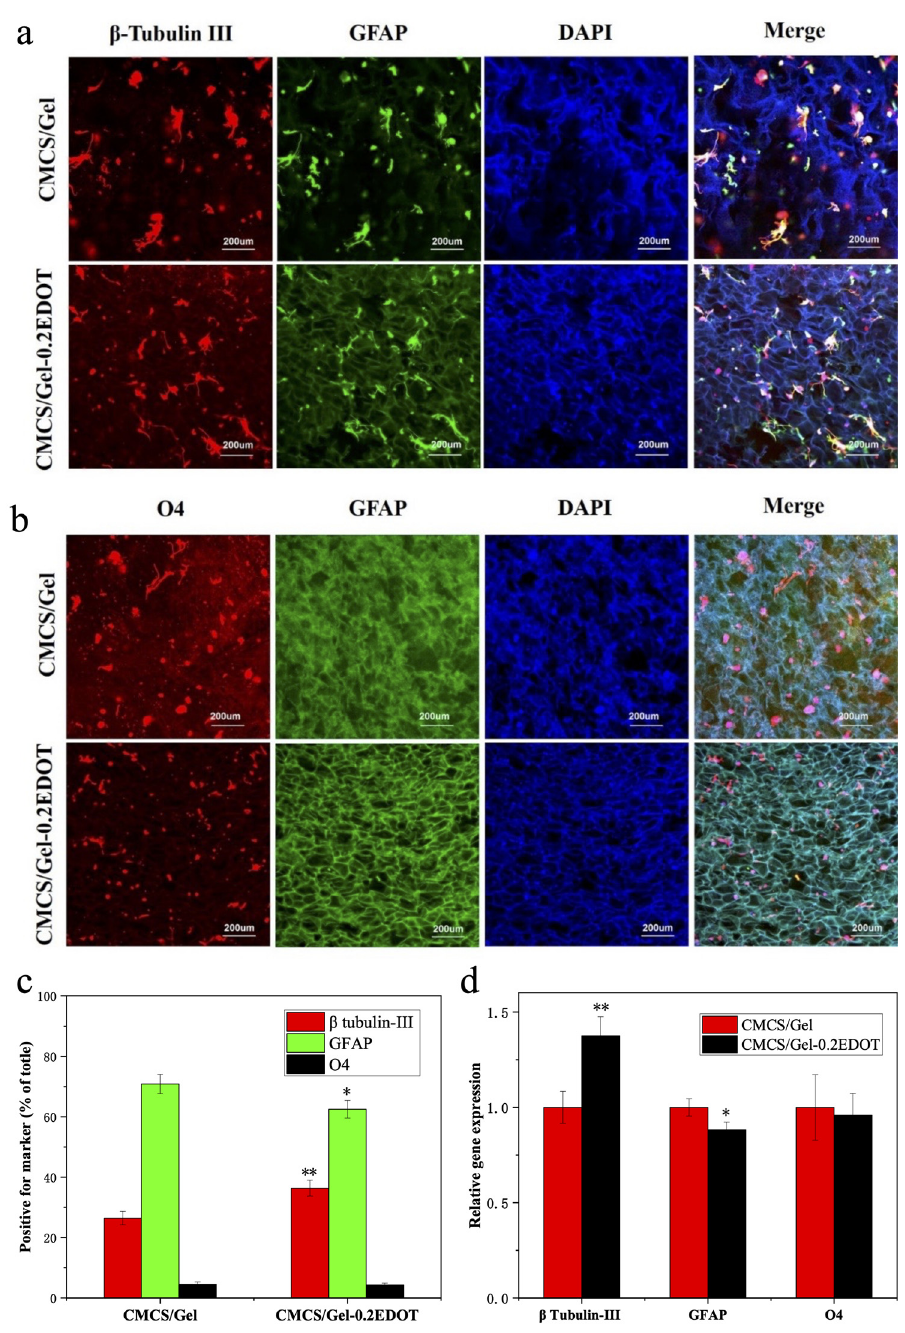
Figure 8. The differentiation of NSCs in CMCS/Gel and CMCS/Gel-PEDOT hydrogels after culture in the proliferation medium for 5 days and in the differentiation medium for 3 days. Neurons are immunostained with β -tubulin III (red), astrocytes are immunostained with GFAP (green), and oligodendrocytes are immunostained with O4 (red). ( a ) The fluorescence immunostaining images for β -tubulin III and GFAP; ( b ) the fluorescence immunostaining images for O4 and GFAP; ( c ) quantification of cells positive for the markers; ( d ) RT-qPCR analysis of the gene expression levels for neurons, astrocytes, and oligodendrocytes. Data are mean ± SD values, and (*) p < 0.05, (**) p < 0.01, statistically different from the CMCS/Gel